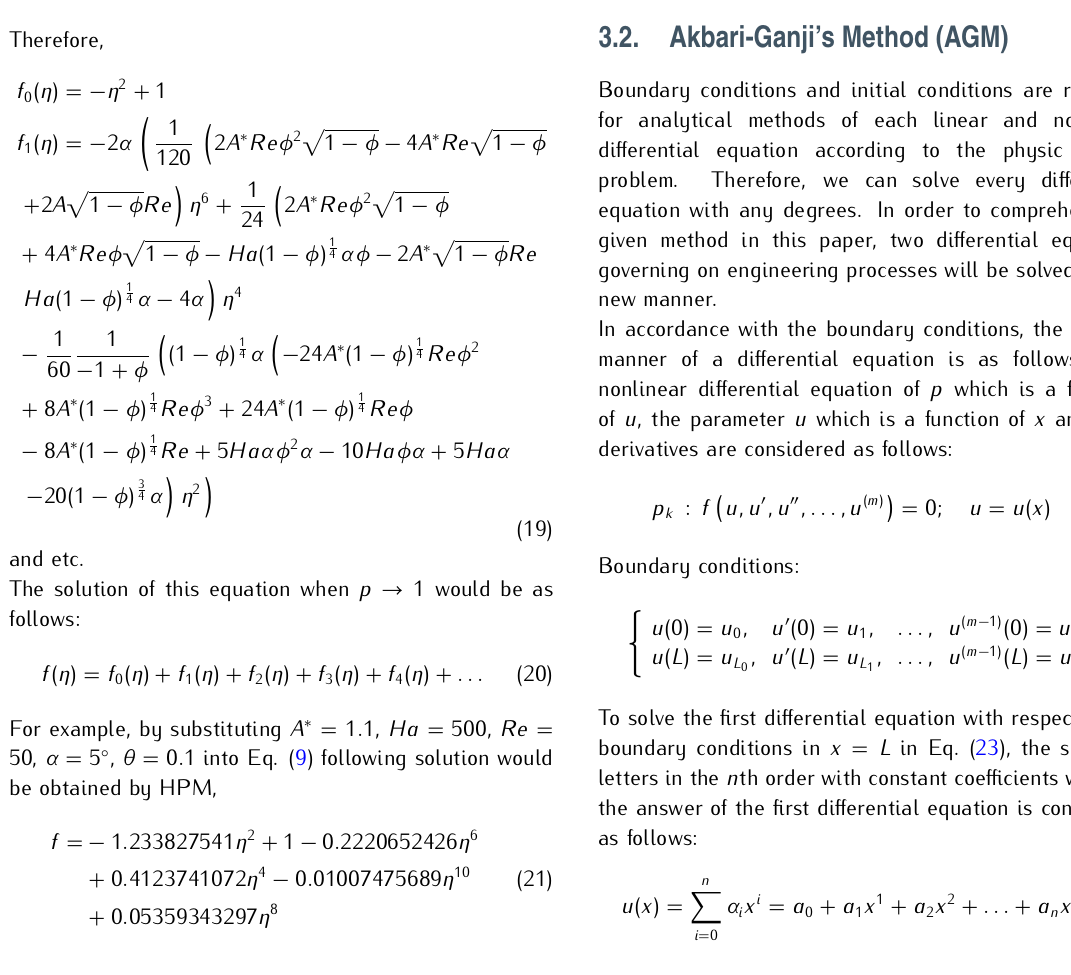
Figure 1. The schematic diagram of the physical